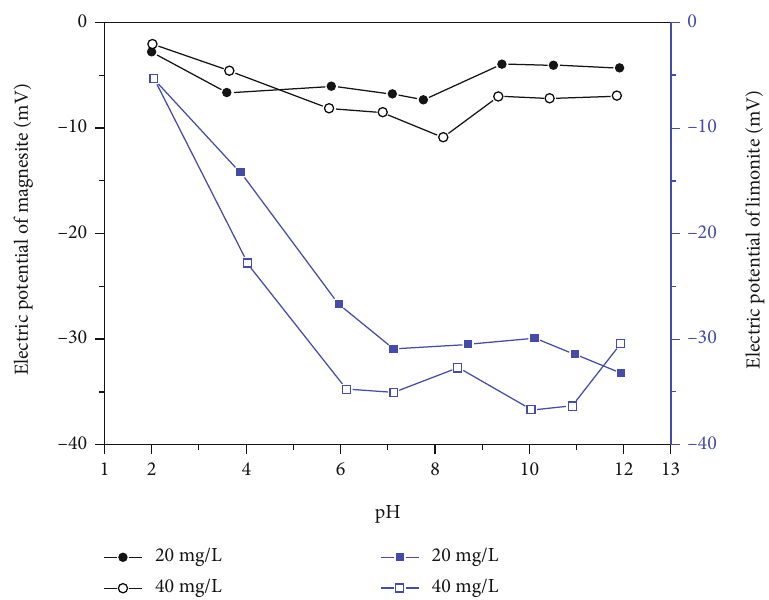
Figure 10: E ff ect of CMC on zeta potential of magnesite and limonite.